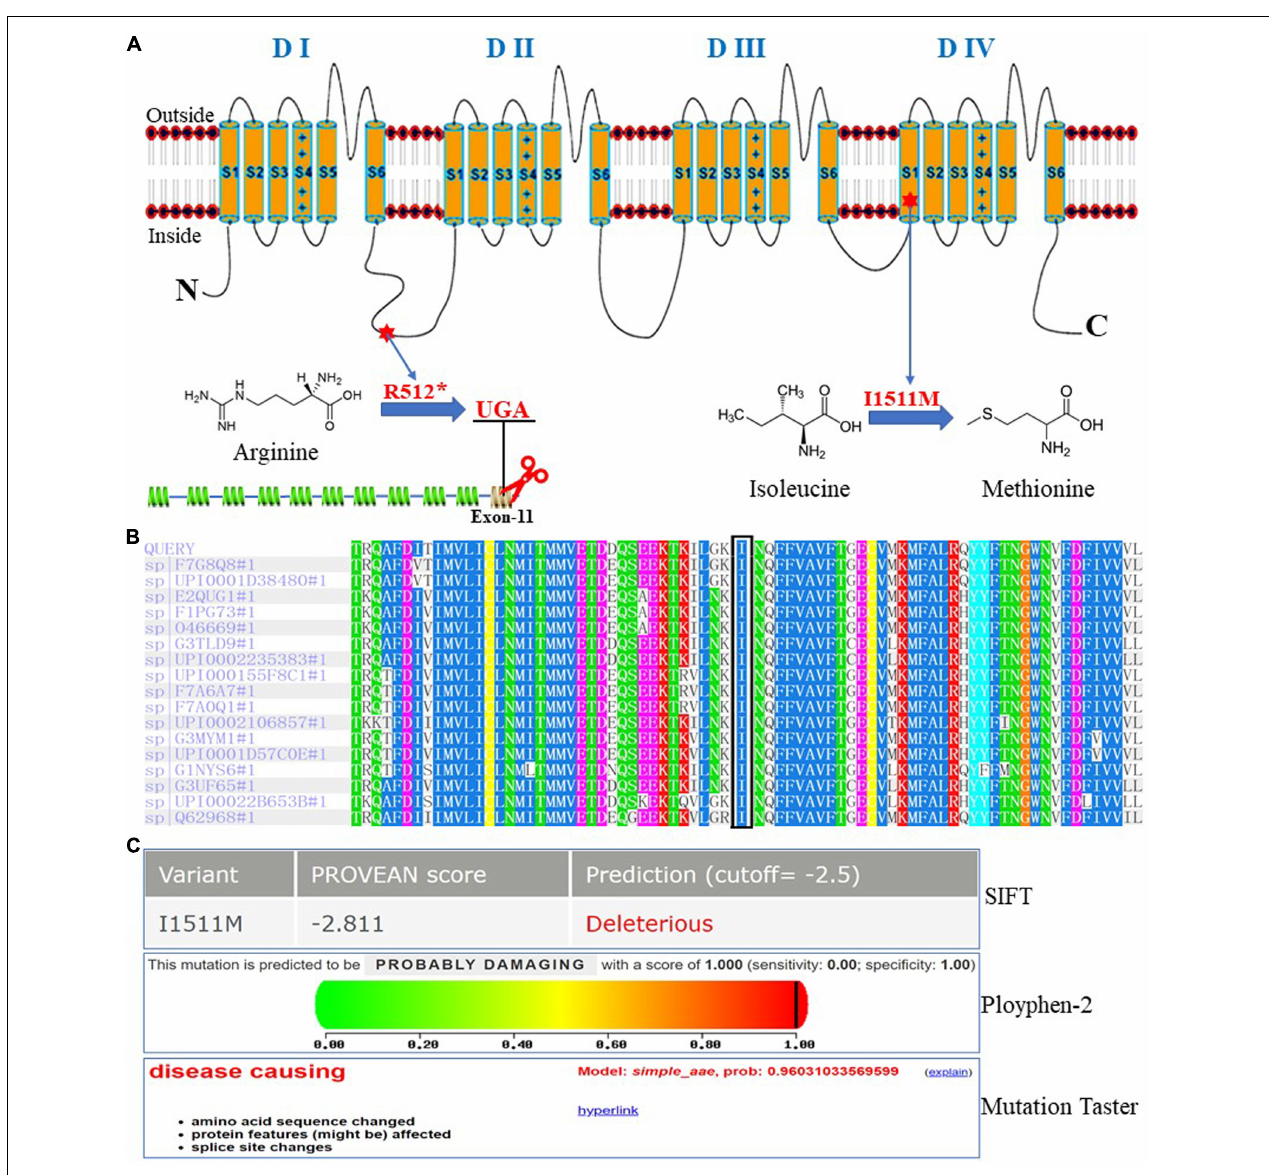
FIGURE 2 | Location, species conservation and predicted effect on protein function of the two identified SCN10A mutations. (A) The mutation sites for two heterozygous SCN10A mutations in Na v 1.8. (B) Species conservative analysis for I1511M. (C) Function prediction analysis for